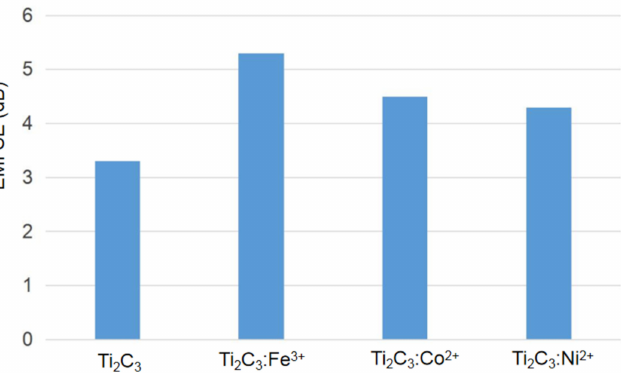
Figure 9. Average shielding effectiveness of Ti 3 C 2 , Ti 3 C 2 /Fe 3+ /Co 2+ /Ni 2+ films from 8.5–15.5